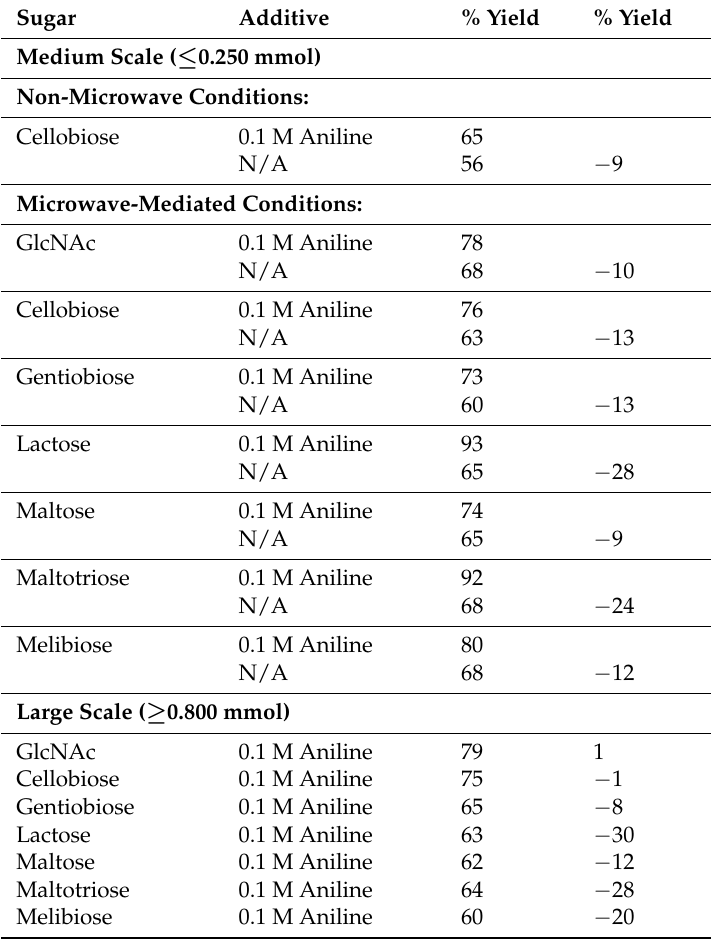
Table 1. Summary of sugar-linker 50 ◦ C traditional and microwave syntheses. Medium scale ( ≤ 0.250 mmol) reactions were run in the presence or absence of 0.1 M aniline (final concentration), while the large scale ( ≥ 0.800 mmol) reactions were all run in the presence of 0.1 M aniline as a catalyst. The ∆ % yield column compares the yields of the medium scale aniline catalyzed reaction with the uncatalyzed reaction of the same scale. For the large-scale reactions, the comparison is between the medium and large-scale aniline-catalyzed reactions.